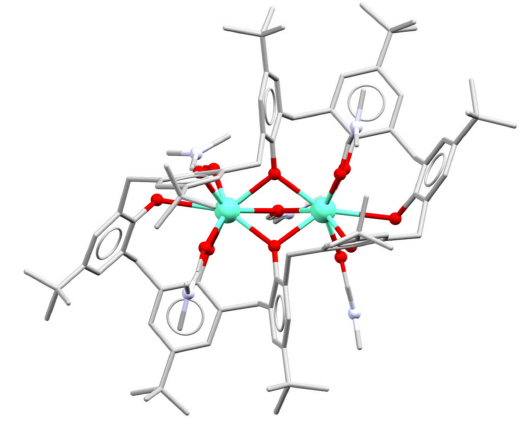
Figure 3. A representation of the bimetallic Eu complex of p -t-butylcalix[8]arene